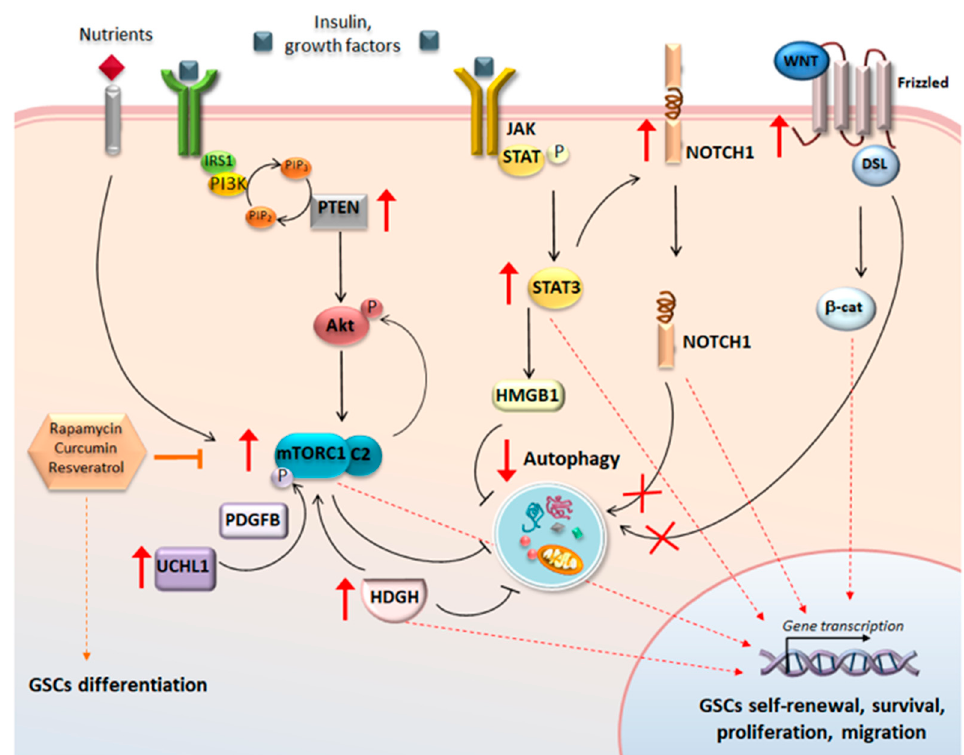
Figure 3. Molecular pathways at the crossroad between autophagy and glioma stem cells proliferation. An interdependency exists between autophagy and the foremost molecular pathways that contribute to GBM features by increasing stemness. For instance, hyperactive mTOR due to either nutrient / growth factor abundance, PTEN mutations, or UCKH1-related PDGFB-dependent phosphorylation of mTORC1, leads to autophagy suppression and mTOR-related transcriptional changes in the nucleus. UCHL1 also enhances mTORC2 stability thus potentiating activation of Akt signaling and mTOR hyperactivation. Again Hedgehog (HDGH) upregulation contributes to activating mTOR, suppressing autophagy and translocating HDGH within the nucleus. Likewise, JAK / STAT signaling leads to upregulation of STAT3, which impairs autophagy through HMGB. STAT3 may also contribute to Notch upregulation, which produces persistent transcriptional changes in the nucleus since its degradation is occluded when autophagy is impaired. Similarly, sustained Wnt / β -catenin activation occurs since the autophagy-dependent degradation of Dishevelled (DSL) is impaired. Altogether these events converge in transcriptional changes, which enhance GSCs self-renewal, proliferation, multi-potency, and migration. Rescuing autophagy through mTOR inhibitors such as rapamycin, curcumin, and resveratrol reverts these biochemical events while promoting GSCs di ff